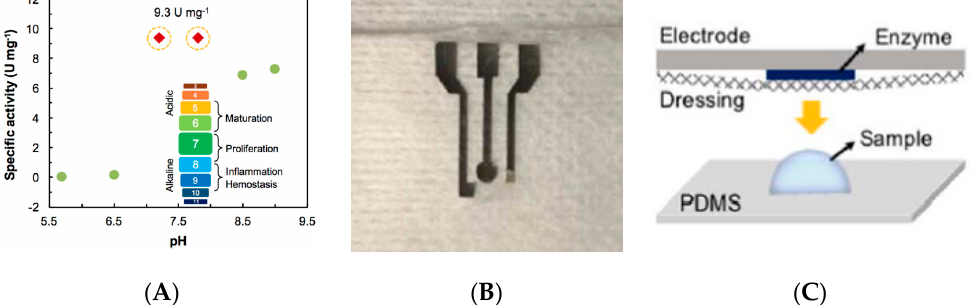
Figure 27. ( A ) Plots show the effects of pH on the specific activity of UOx. The red diamond markers denote higher activity of urate oxidase (UOx). The inset image represents the relationship between the wound healing stages and pH. ( B ) Screen-printed graphite + UA electrode on a dressing. ( C ) Experimental setup. Reproduced from [81]. © the author(s) 2018. Published by ECS. http://creativecommons.org/licenses/by/4.0/.